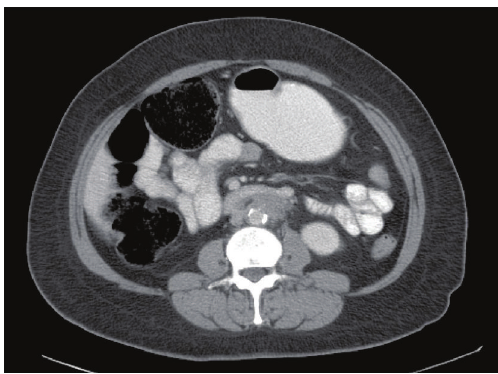
Figure 1: Abdominal computed tomography featuring the aorta with surrounding soft tissue mass.